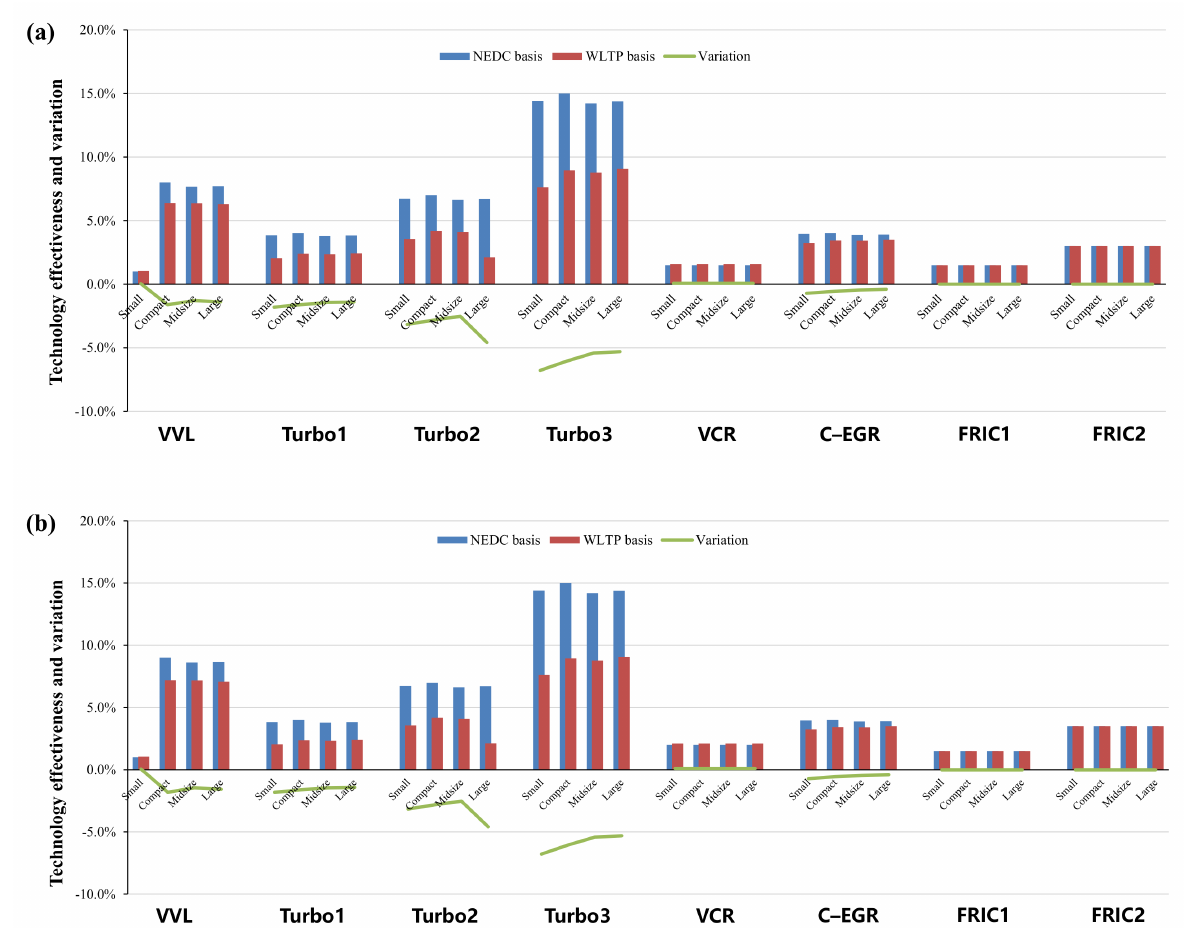
Figure 6. ( a , b ): Comparisons of advanced diesel engine technologies in 2025 and